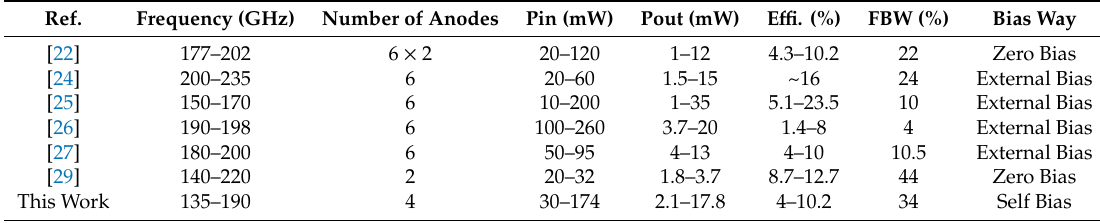
Table 3. Comprehensive comparison of reported frequency